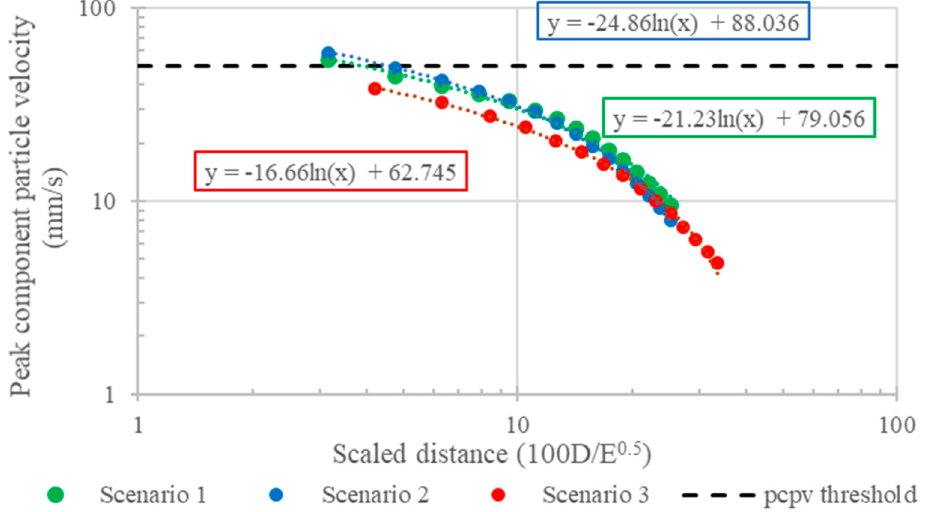
Figure 8. Comparison between different excavation scenarios: variation with scaled distance of the peak component particle velocity.